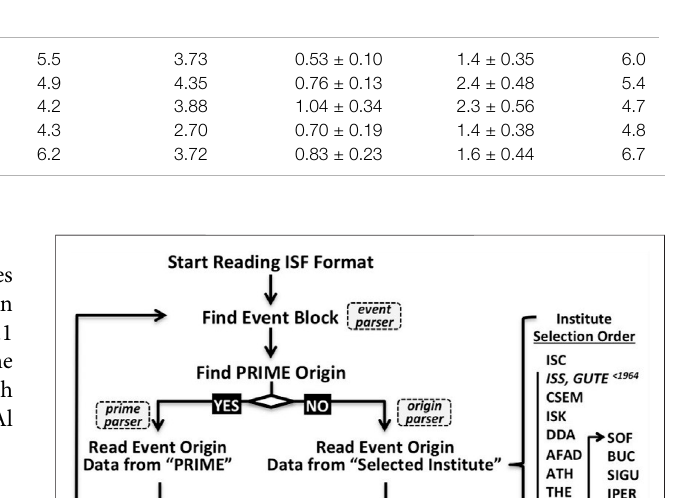
TABLE 1 | Number of earthquakes, magnitude, and depth ranges; seismicity and seismic hazard parameters for the studied regions in the Arabian Shield. Regions Total no.